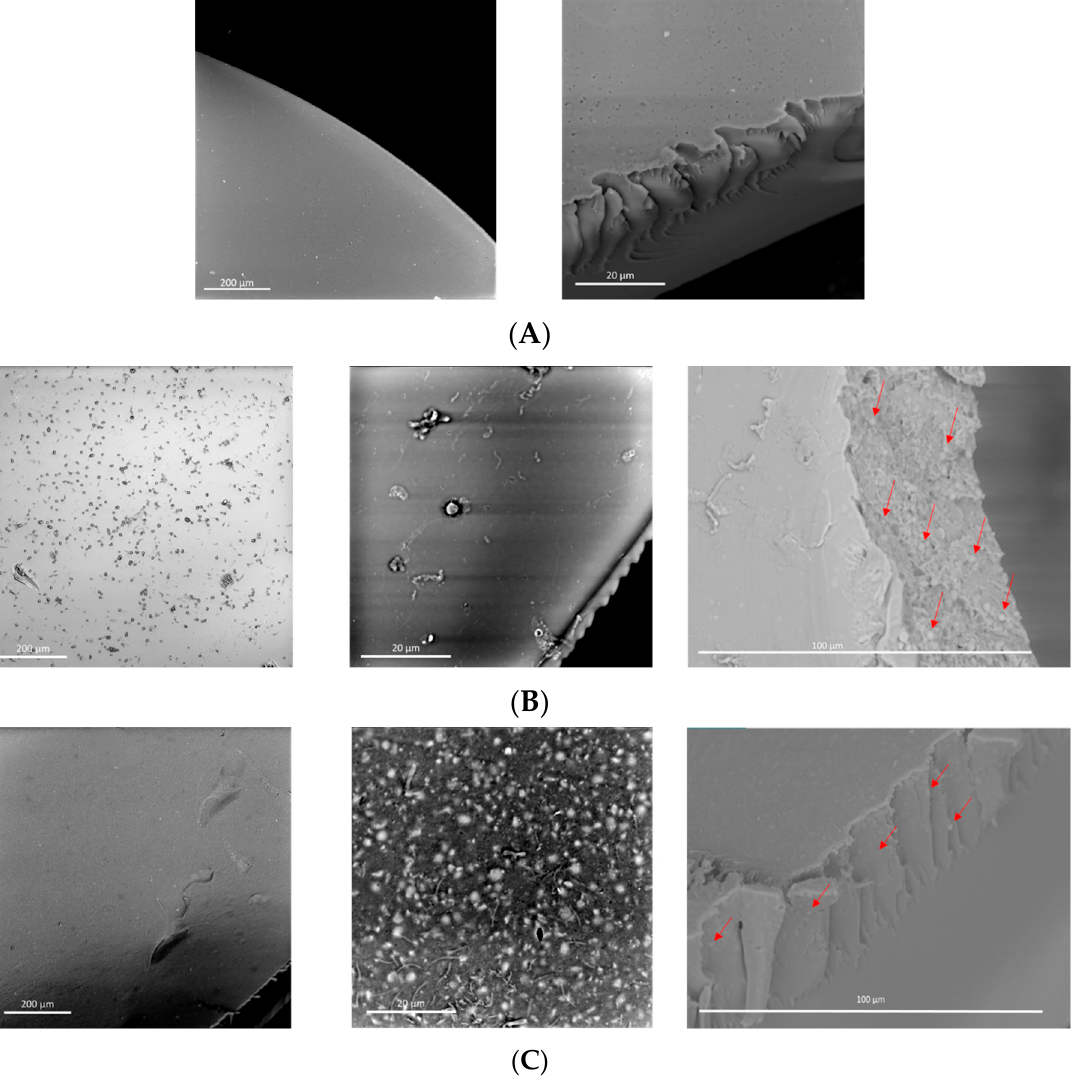
Figure 12. SEM micrographs of the membranes prepared from the polymer HMW-sPEES with ( A ) 0% MCF; ( B ) 6% MCF-NH 2 ; and ( C ) 6% MCF-SO 3